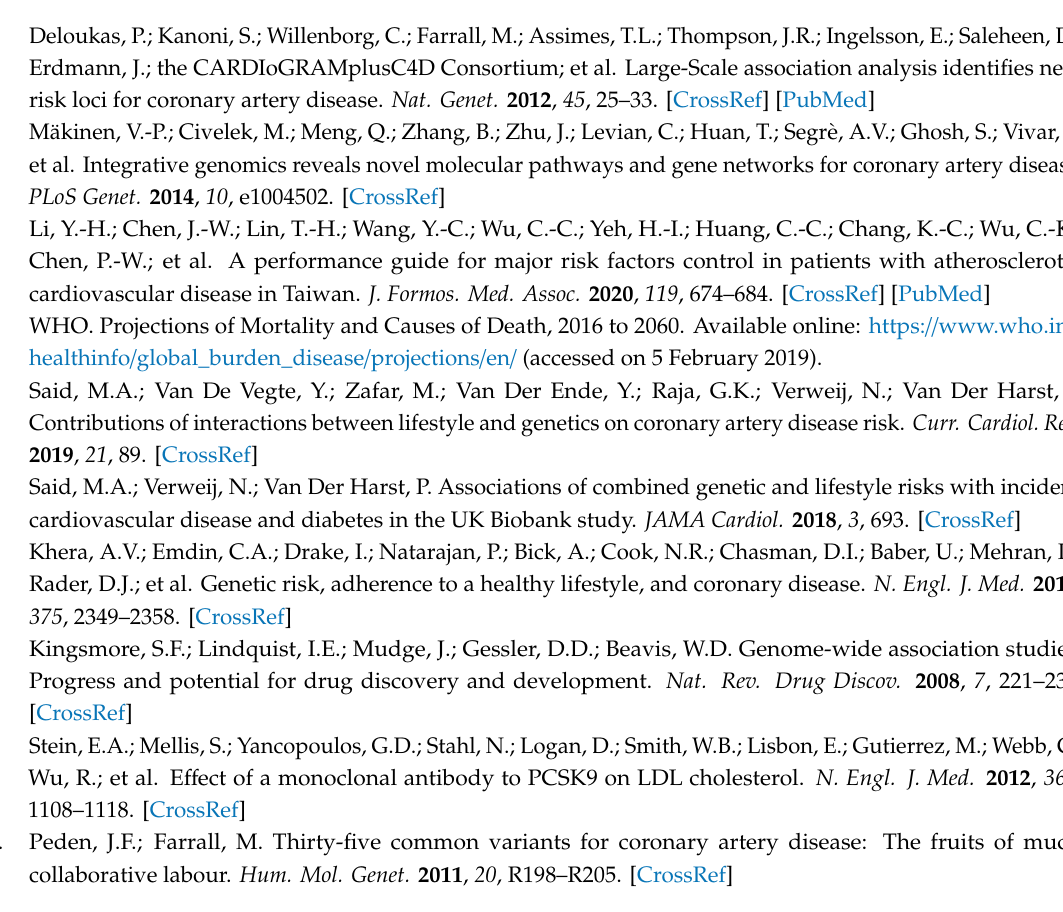
Table S1: Association of CHD with rs762551 variant and associated factors, Table S2: Association of CHD with co ff ee drinking stratified by rs762551